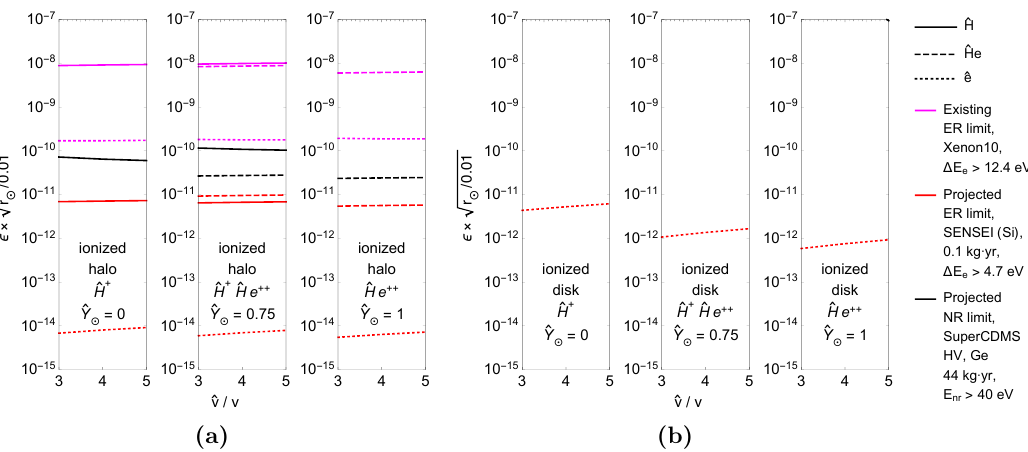
Figure 5 . Constraints on photon kinetic mixing (cid:15) from direct detection of mirror H, He and electrons at Xenon10 (ER, existing constraint) or SuperCDMS and SENSEI (NR and ER, projected constraints) for the ionized halo (a) and the ionized disk (b) distributions. The mirror particle masses and velocity distributions depend on ˆ v/v and the mirror helium fraction ˆ Y , see section 4.1 for details. The limits for partial ionization are very similar to the shown cases of full ionization. Note that the disk limits do not take the increased local DM density into